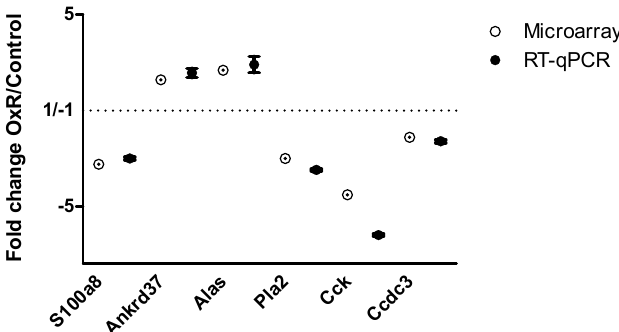
Figure 6. Confirmation of significant microarray results by reverse transcription quantitative PCR. Fold change in gene expression level by oxygen restriction (OxR) over values observed in control group of S100a8, Ankrd37, Alas, Pla2g2e, cholecystokinin (Cck), and coiled coil domain containing 3 (Ccdc3) was analyzed by RT-qPCR (closed circles, n = 10), relative to stable reference genes B2m and Rps15. Data obtained with microarray analysis is shown for comparison by open circles. Data are shown as mean ± SEM.